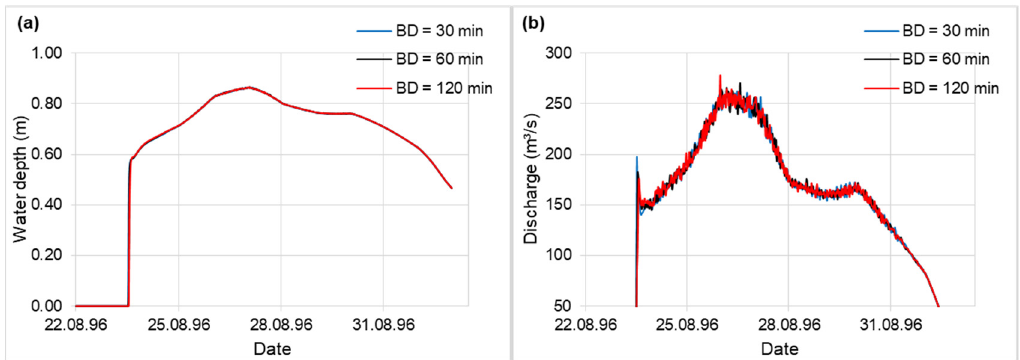
Figure 8. For the indicated levee breach durations (BD) and the historical levee breach location of the August 1996 levee breach flood event at Wonji: ( a ) modelled water depth at an office location; ( b ) modelled breach discharge. The office location and the historical breach location are shown in Figure 3.